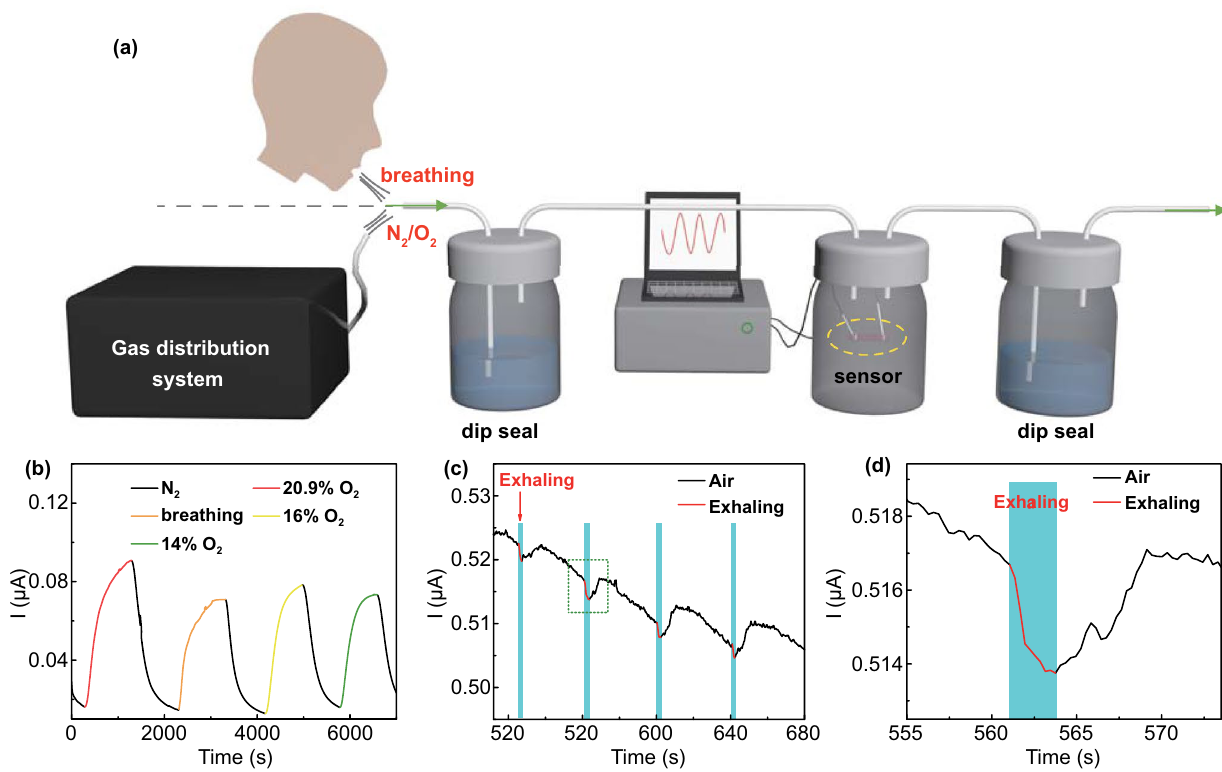
Fig. 7 Application of the sensor in human respiration monitoring. a Schematic illustrating the setup for real-time detection of O 2 concentration in human exhaled breath. b Dynamic response to 20.9% O 2 , exhaled breath, 16%, and 14% O 2 . c Real-time response to the gas exhaled by the human in the air. d Magnified image of the green box in